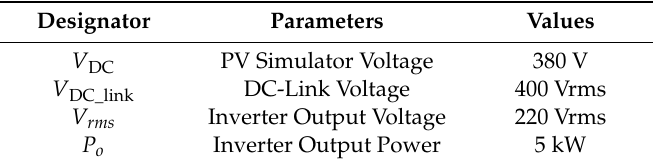
Table 1. Specification of the System.